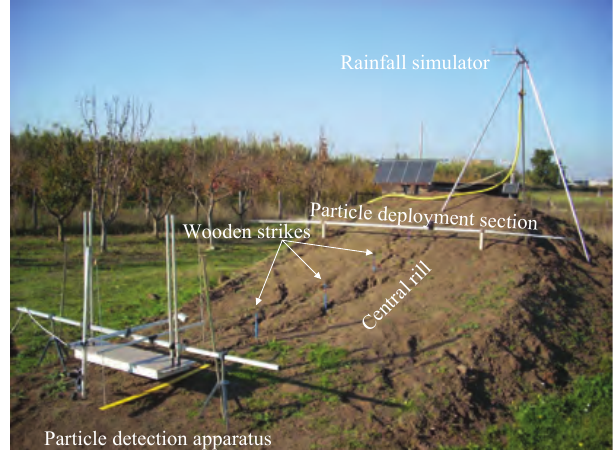
Fig. 2. Experimental apparatus including the light source and the video acquisition units. The metric ruler is used for calibrating ac- quired videos.